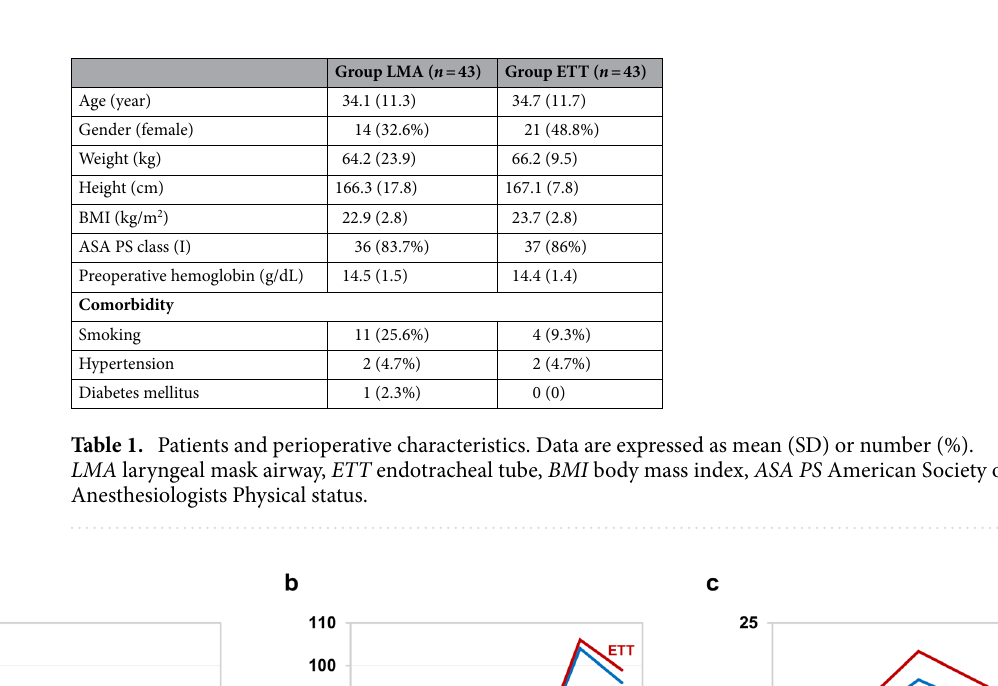
Figure 1. CONSORT diagram. LMA laryngeal mask airway, ETT endotracheal tube.